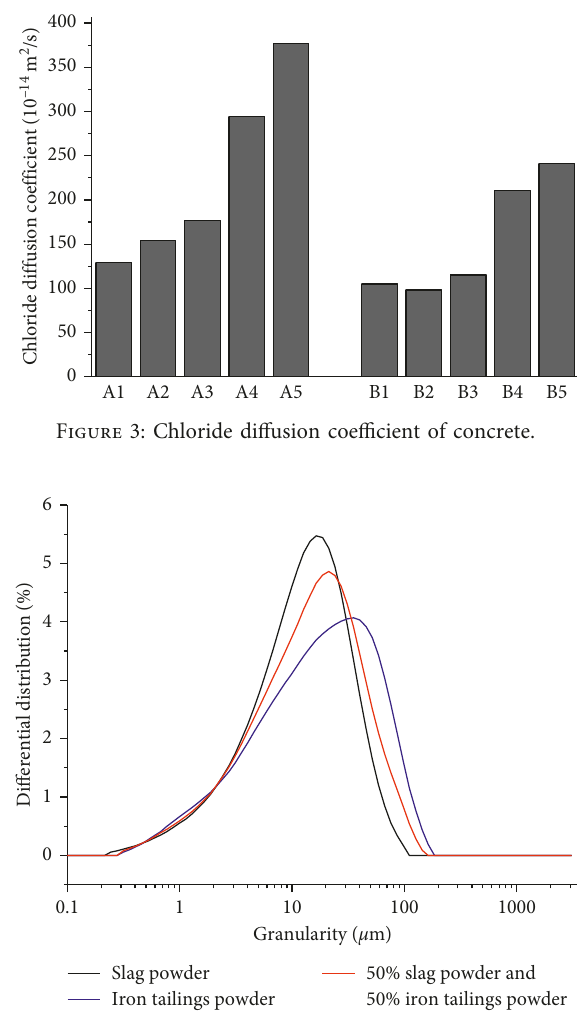
Figure 4: Particle size distribution of cementing